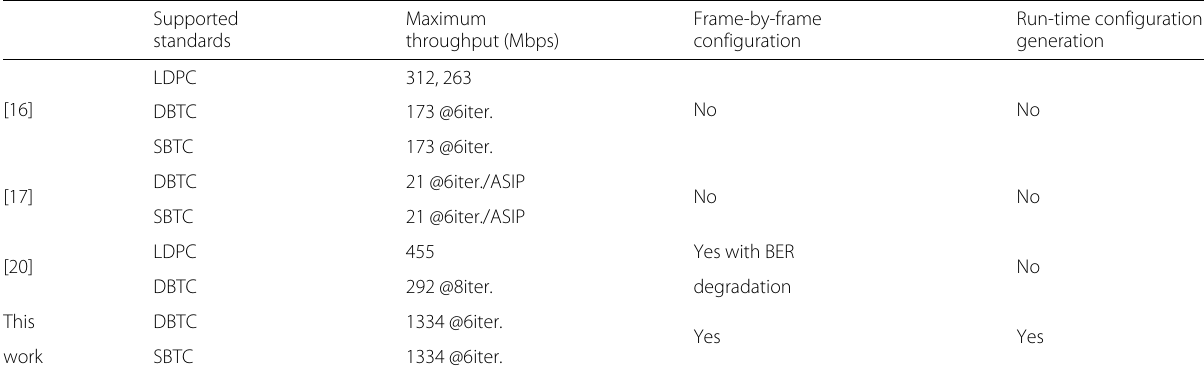
Table 7 Comparison of supported dynamic configuration features with relevant existing